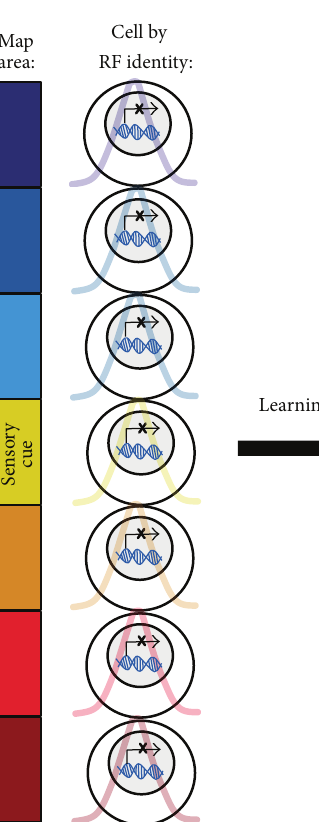
Figure 3: Strong and specific long-term memory formation via sensory cortical neurons. Applying a systems-level approach to model epigenetic influences on the robustness of memory in a sensory cortex. Distinct and discrete representations of the external sensory world (color heat map, left panel ) are mapped onto cortical areas bounded by similar receptive fields (RFs) that reveal the neural “tuning” identity for sensory signals (colored curves underlying each neuron, left panel ). As per the conceptualization described in Figure 2, learning events can target a selected subset of sensory neurons that have neural tuning to the various sensory cues available during an experience. Of those targeted, a lowered threshold for memory induction will facilitate specific memory for the behaviorally relevant sensory cues and features represented by neurons tuned to those features. These neurons would therefore be engaged with gene expression for subsequent neural plasticity. The right panel depicts one possible outcome for sensory cortical map plasticity: an enlarged representation of a behaviorally significant sensory cue (color heat map, left panel ). For example, the magnitude of tone-frequency expansion in the frequency map of A1 has been shown to directly relate to the specificity and strength of auditory memory: more cells, then stronger memory [14, 15]. The general outcome of this framework is for more sensory information to be encoded by the activity and plasticity of those neurons tuned to the behaviorally relevant stimuli, which ultimately results in a robust memory